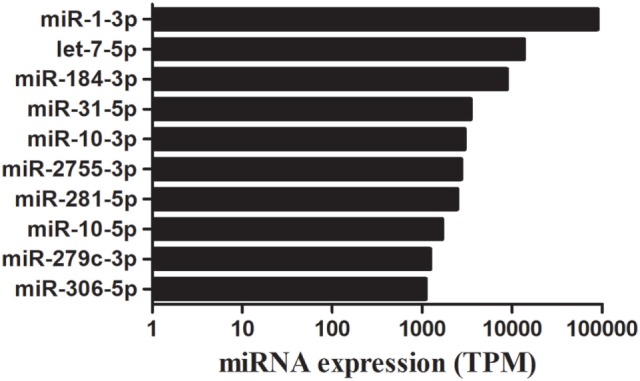
A time course of destruxin A-responsive top 10 abundantly expressed microRNA (miRNAs) in Plutella xylostella. Average expression value of all time courses is presented here. TPM, transcripts per million.